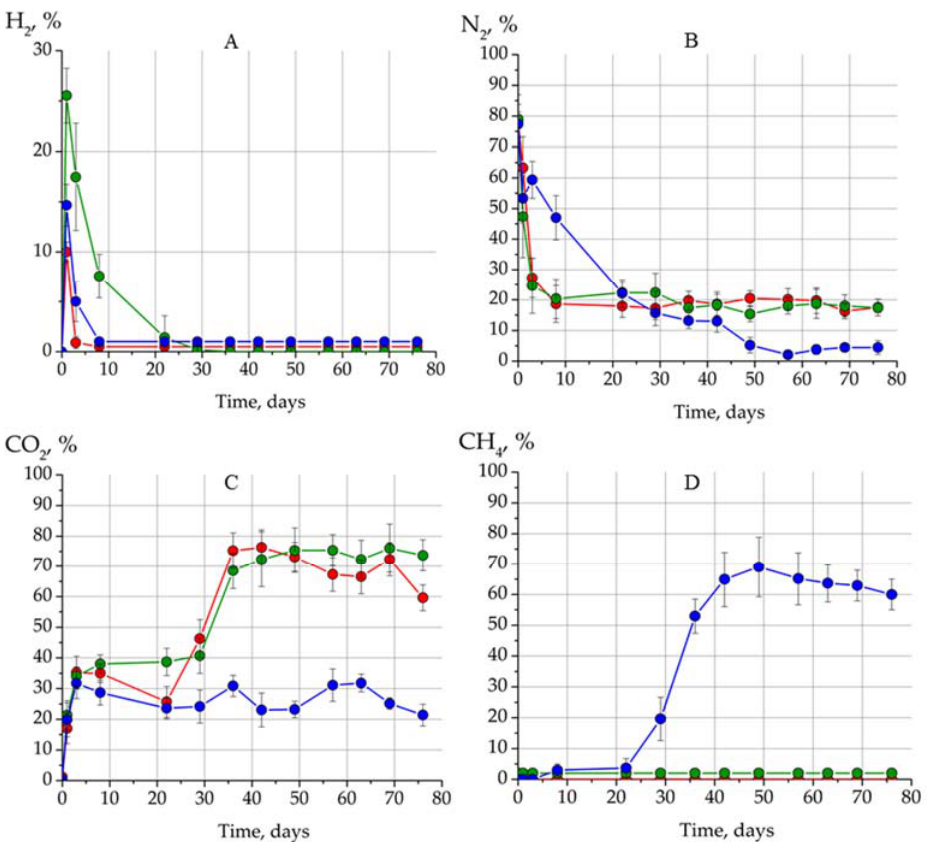
Figure 5. The composition of the gas phase (( A )—H 2 ; ( B )—N 2 ; ( C )—CO 2 ; ( D )—CH 4 ) during fermentation of P. stratiotes L. plants in control conditions without GMP (red lines), in the presence of GMP1 based on hydrogen-synthesizing microorganisms (green lines), and in the presence of GMP2 based on methane-synthesizing microorganisms (blue lines).